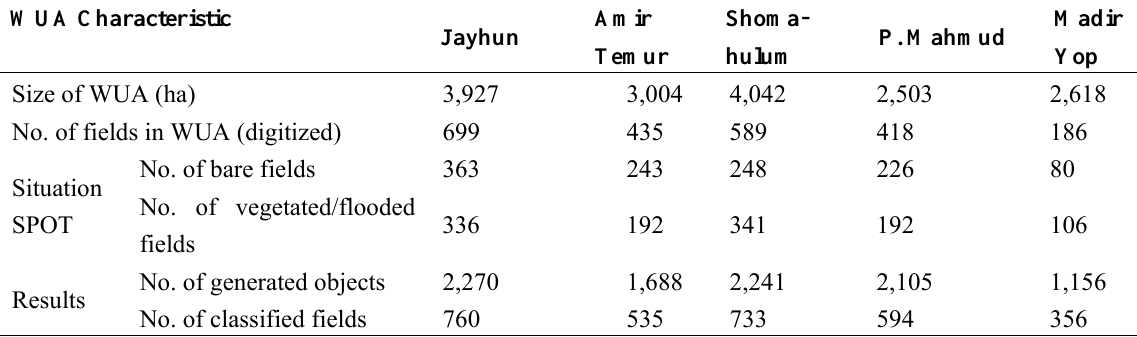
Table 4. Object-based statistics of the investigated WUAs resulting from SPOT segmentation and field